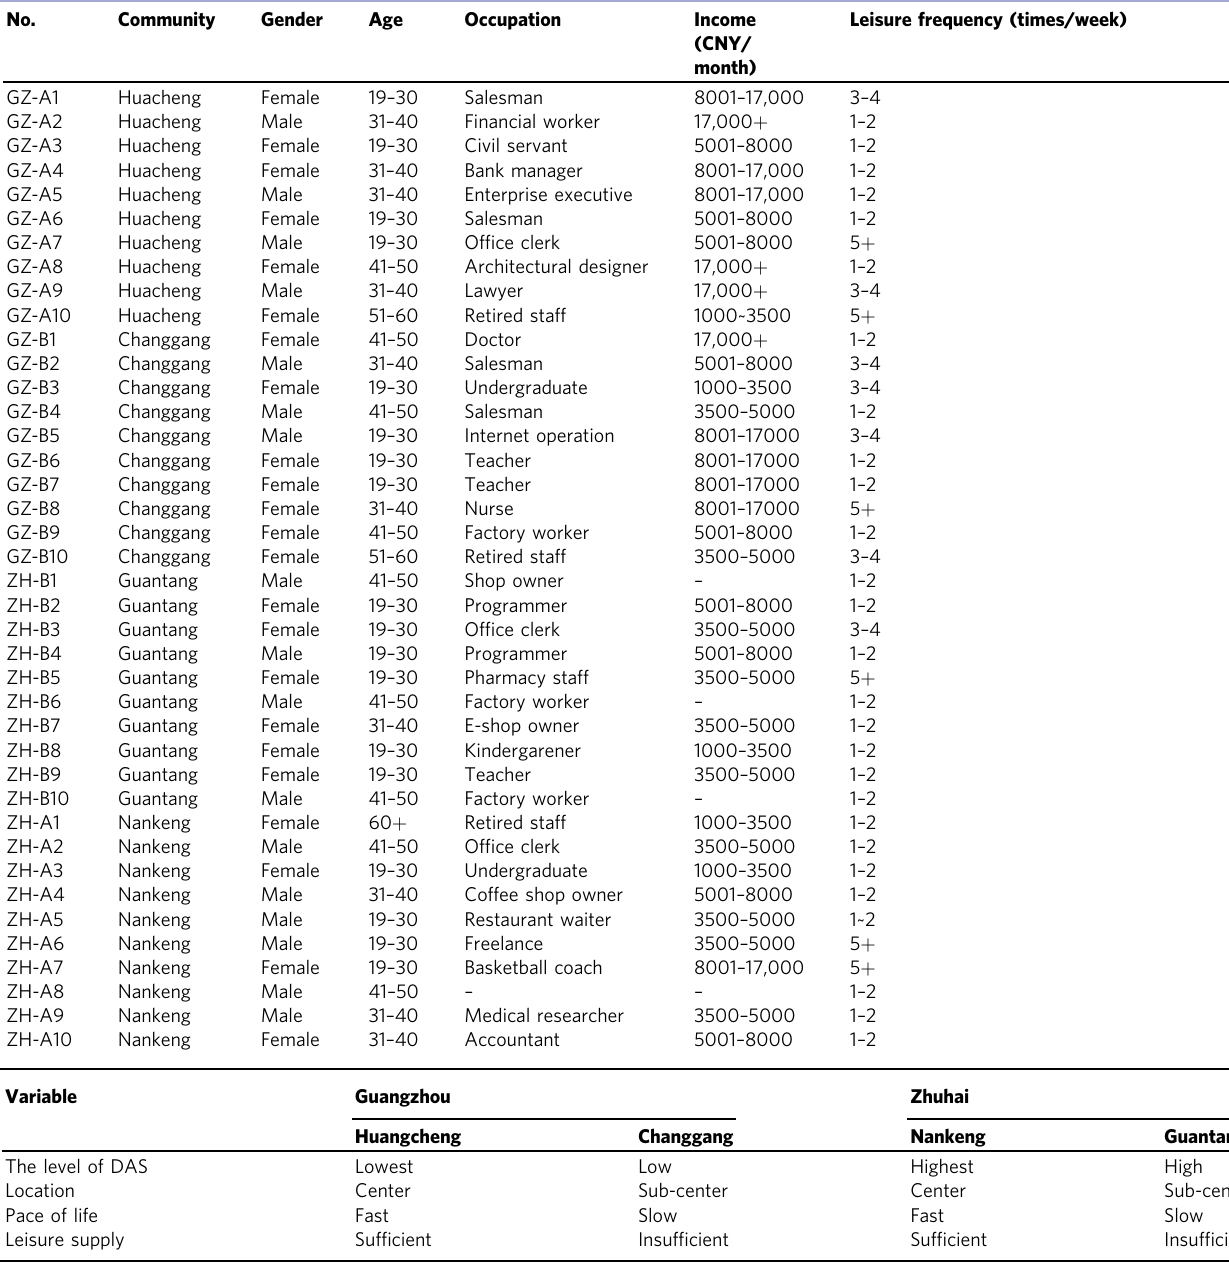
Table 4 Details of (a) samples and (b) case